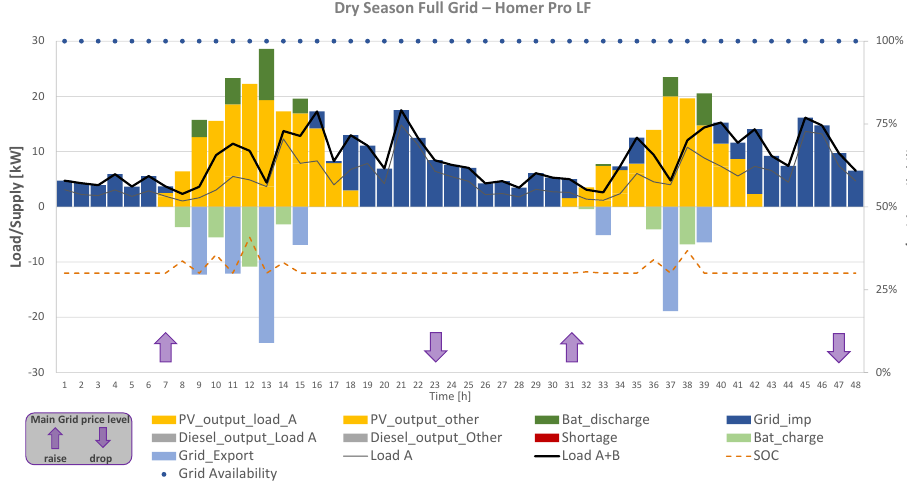
Figure 13. HOMER Pro’s LF strategy for dry season full grid.